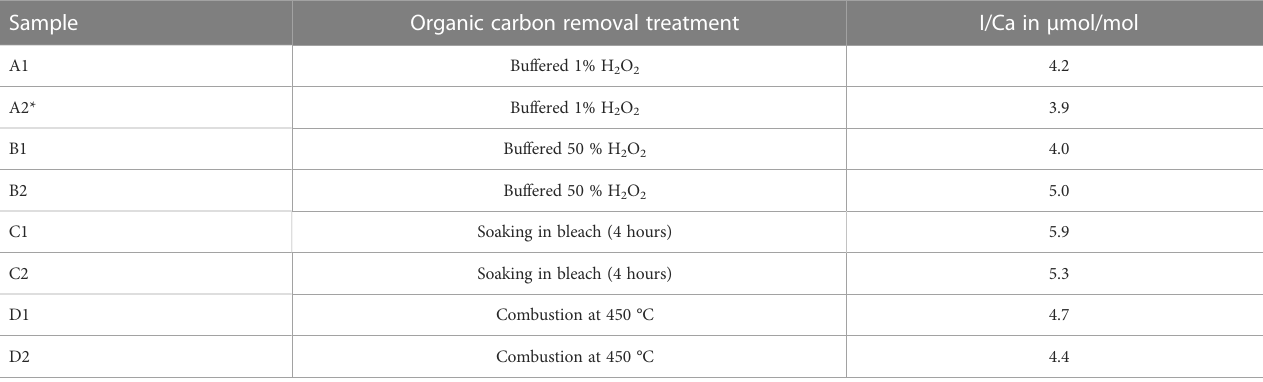
TABLE 2 Effect of different organic material removal techniques on core-top sample from ODP 1088 (0-1 cm, > 300 µm Globigerina bulloides ).